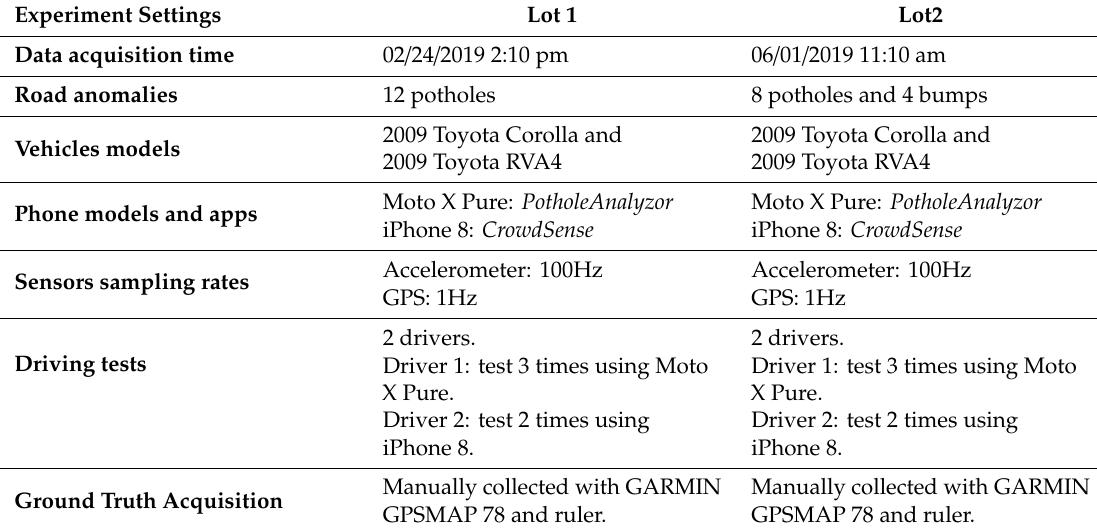
Table 1. Experiment settings.